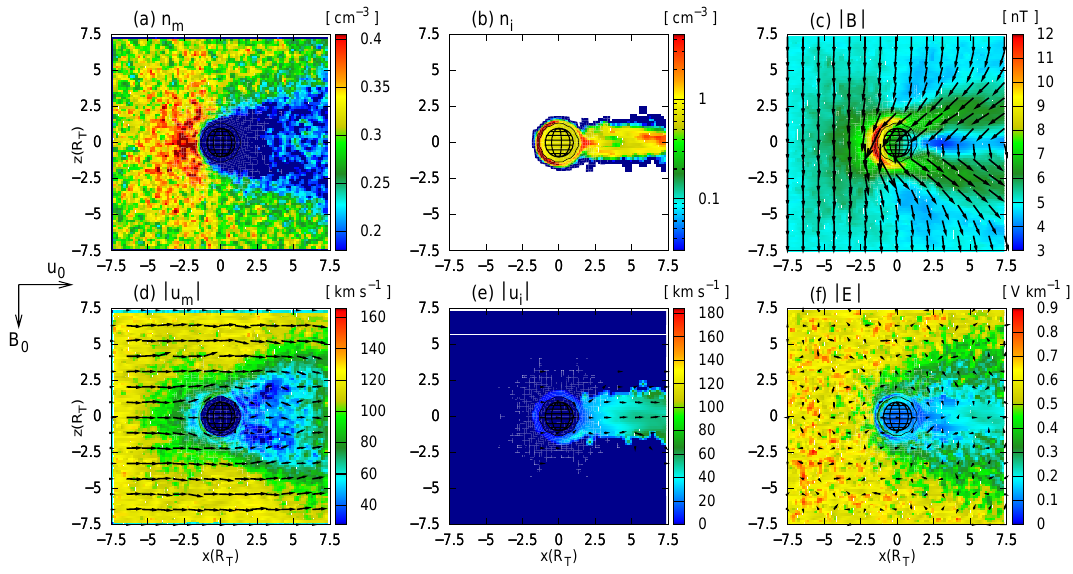
Fig. 9. Transition from supermagnetosonic to submagnetosonic flow – Cut through the (x,z) plane of the coordinate system which coincides with Titan’s polar plane. The figure displays the (N + / H + ) plasma density and velocity: (a) and (d) , the ionospheric ion density and velocity: (b) und (e) , and the electromagnetic fields: (c) and (f) . The figure illustrates the transition from the case of Titan being located outside the magnetosphere, where all three Mach numbers are larger than 1, to the case of Titan’s interaction with Saturn’s magnetospheric plasma at 18:00 LT. Mach numbers of the upstream plasma flow: M A =1.87 (alfv´enic), M S =1.08 (sonic) and M MS =0.94